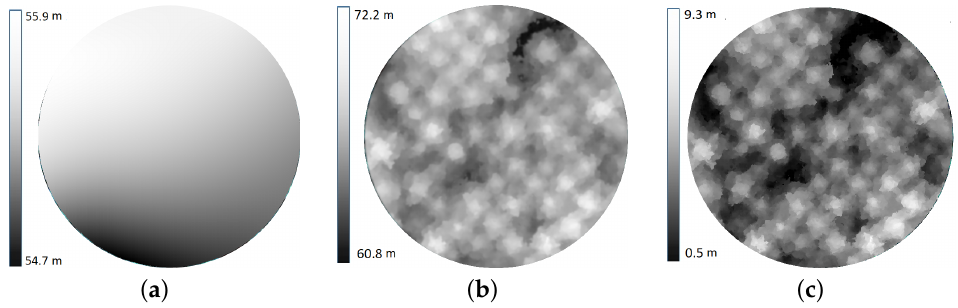
Figure 4. The digital elevation model ( a ) representing the ground surface height is subtracted from the digital surface model ( b ) representing the canopy surface height to derive the canopy height model ( c ) representing the real height of canopy in